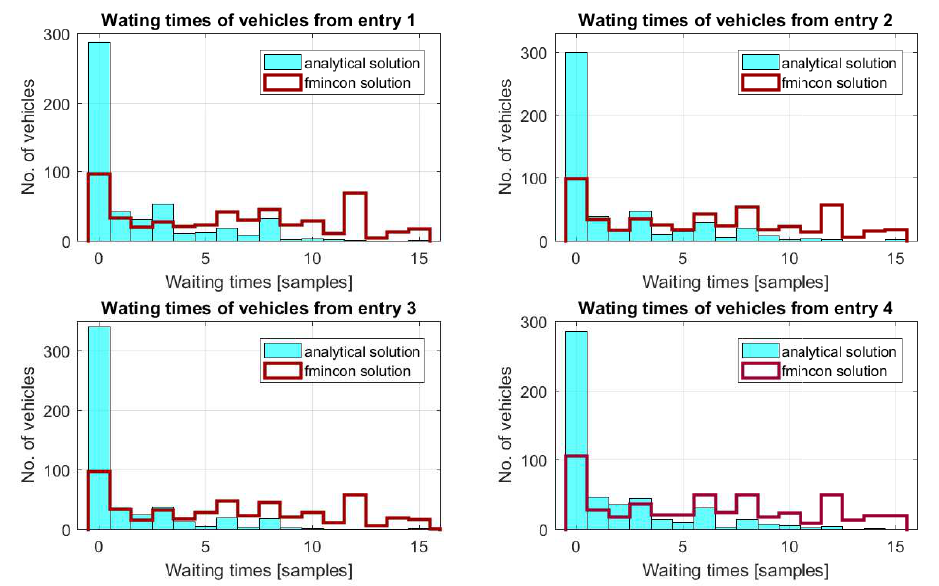
Figure 5. Waiting times of the